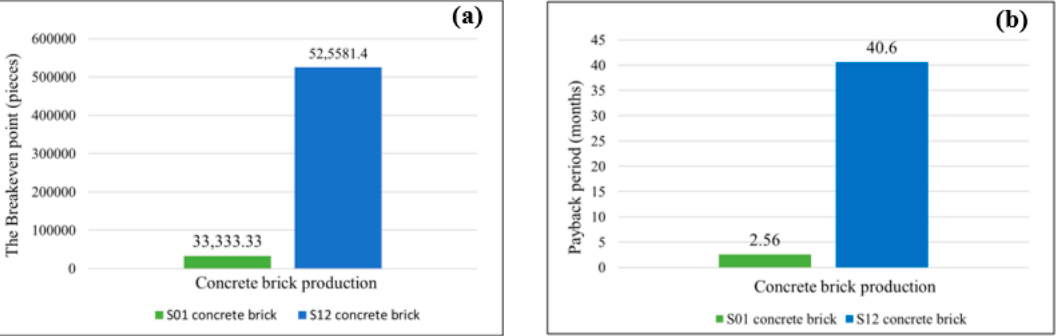
Figure 12. ( a ) Breakeven point comparison of brick production between S01 and S12; ( b ) payback period comparison of brick production between S01 and S12.